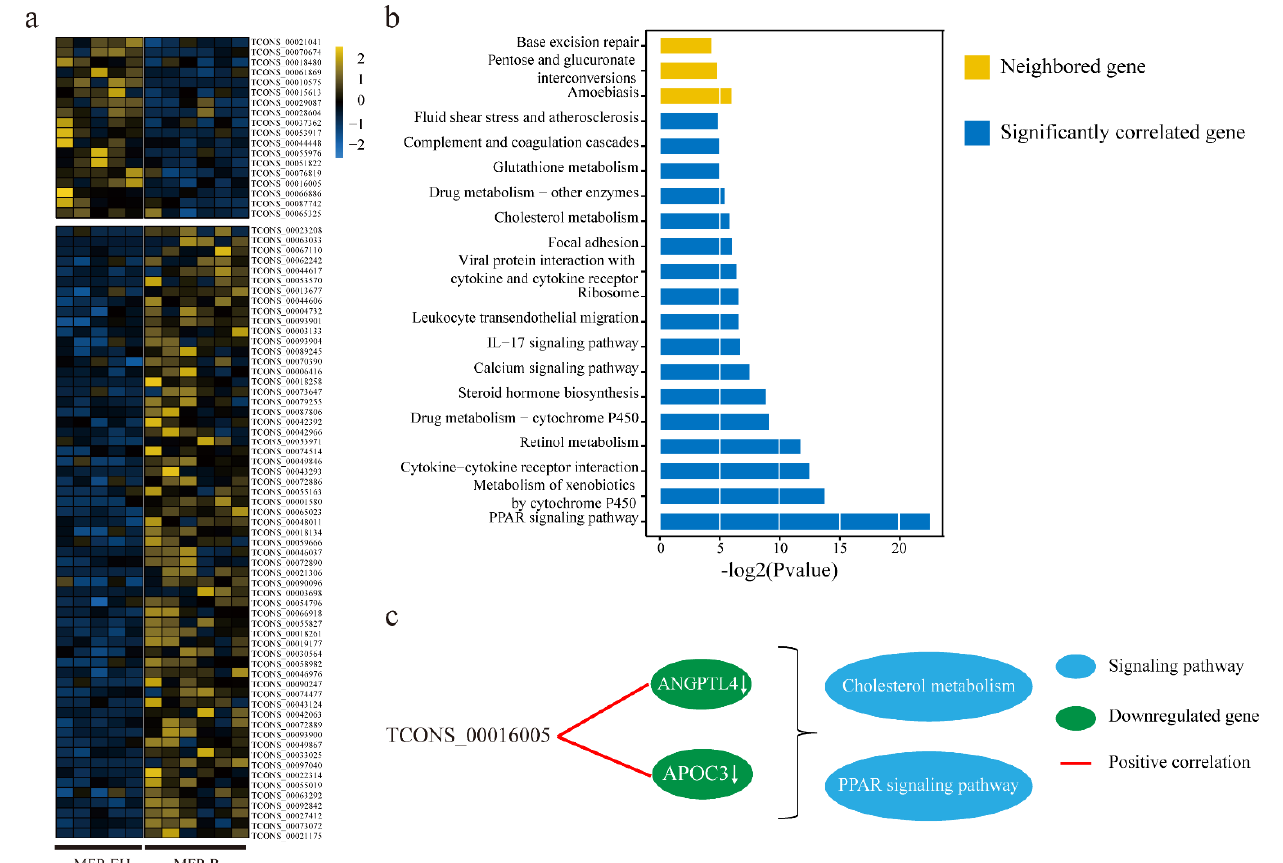
Figure 3. Functional analysis of differentially expressed lincRNAs (DELs) in mammary fat pad (MFP) under enhanced milk replacer (EH) vs restricted milk replacer (R). ( a )The heat map of DELs in MFP under EH vs R. ( b ) The pathway analysis of DELs’ neighboring genes and significantly correlated genes (yellow, represent DELs’ neighboring genes; blue, represent significantly correlated differentially expressed genes (DEGs)) in MFP. ( c ) The selected DELs highly correlated with DEGs. (Arrow represent these genes were involved in those pathways) Table 1. Differentially expressed lincRNAs’ (DELs’) neighbored DEGs in PAR and MFP.